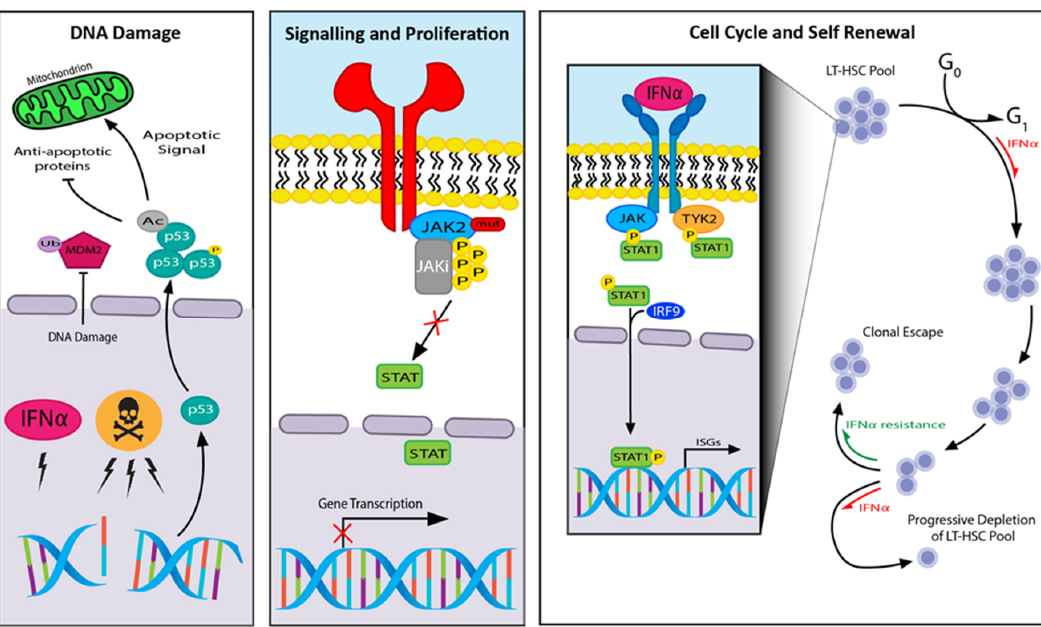
Figure 4. Treatments in MPN and the mechanism of action to control the disease through DNA damage, signalling and proliferation and cell cycle and self-renewal effects: Toxic symbol, chemotherapeutic agents; JAKi, JAK inhibitor; IRF9, interferon regulatory factor 9; ISGs, interferon-stimulated genes; TYK2, tyrosine kinase 2.